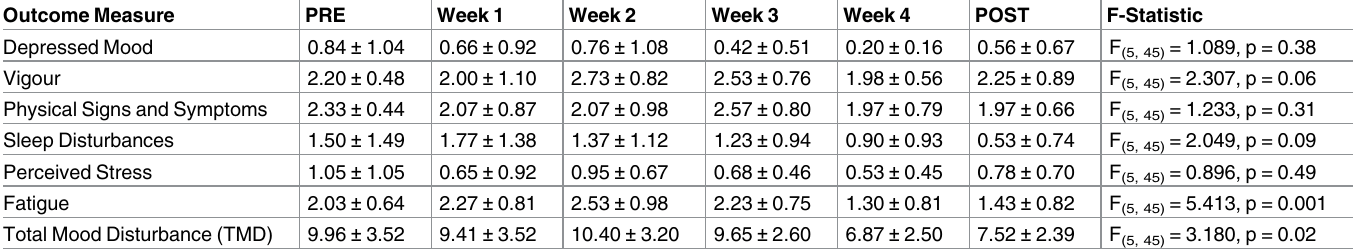
Table 3. Multi-component Training DistressScore (MTDS) parameters throughout the four-week training cycle. Data are presentedas mean ± SD. Results from a one-wayrepeatedmeasures ANOVA for each componentare presentedas the F-statistic for Tests of Within-Subjects Effects. Outcome Measure PRE Week 1 Week 2 POST